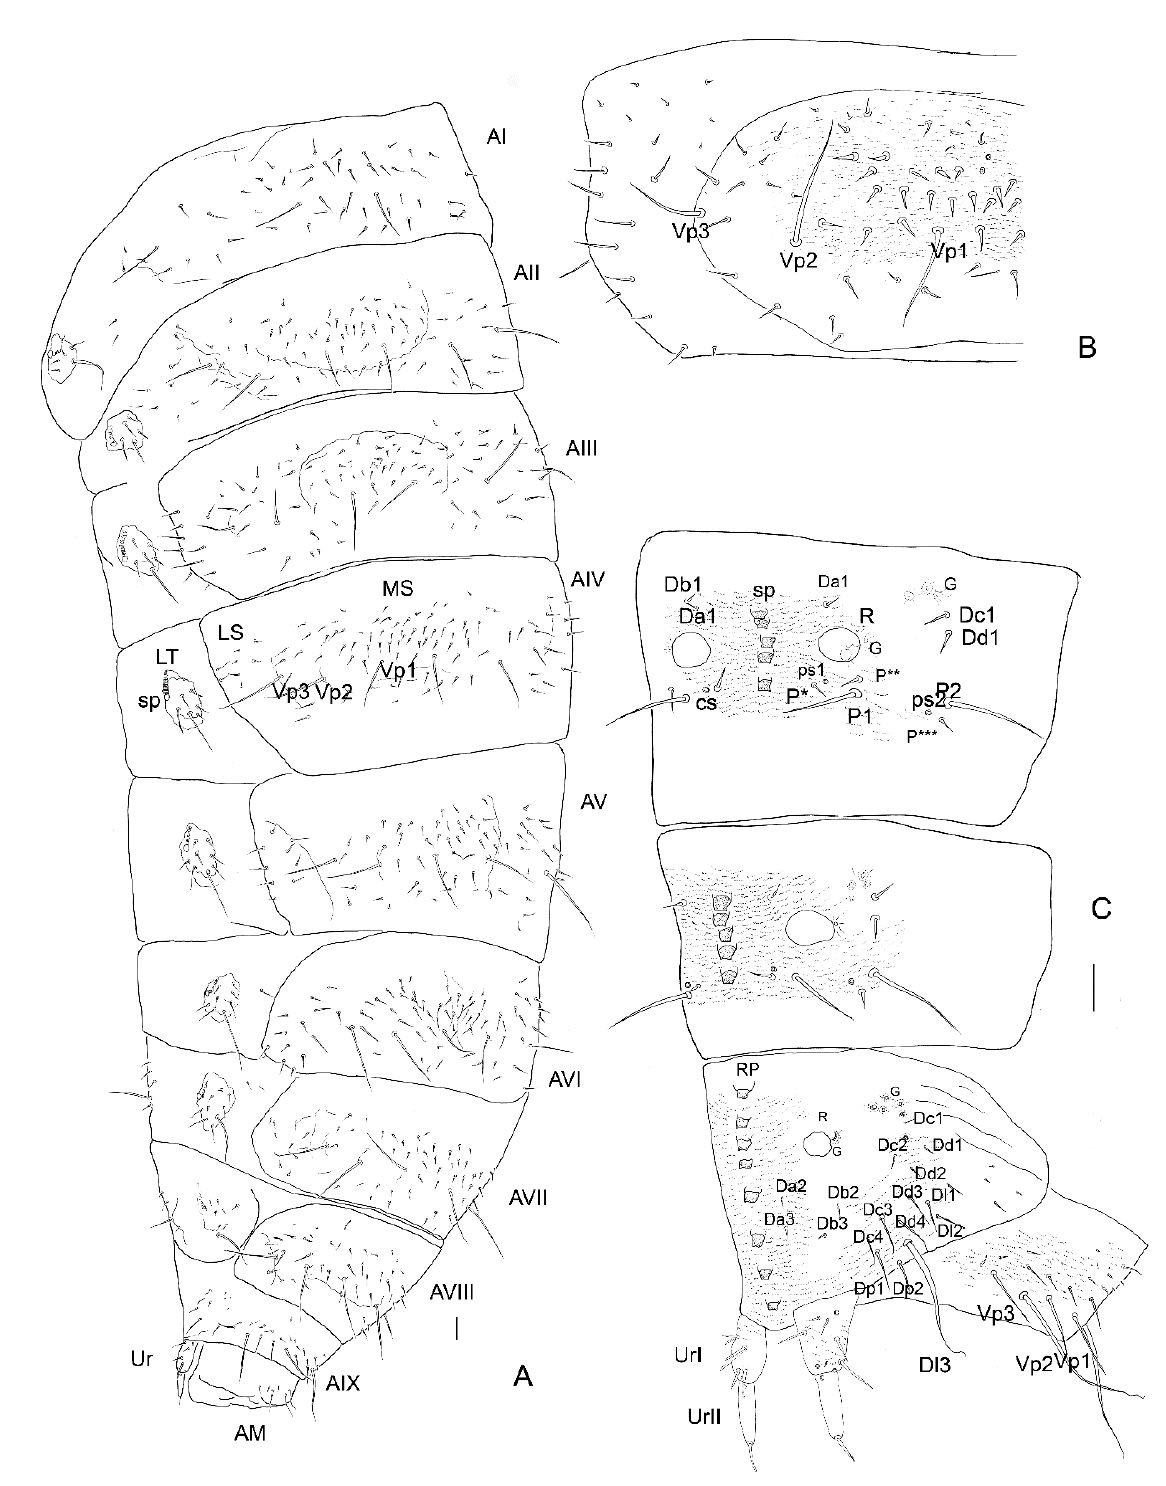
Figure 16. Leiodes cinnamomea. Details of larval morphology of instar III. ( A ) Abdominal tergites and laterotergites I–IX and anal membrane. ( B ) Abdominal sternite II. ( C ) Abdominal tergites VII–IX with urogomphi. Abbreviations: AI–IX—abdominal tergites I–IX; AM—anal membrane; LS— laterosternite; LT—laterotergite; MS—mediosternite; R—reservoir; RP—rectangular plate; Sp— spiracle; UrI, II—urogomphere I, II. The other abbreviations refer to the terminology of setae. Scale bars = 0.1 mm.